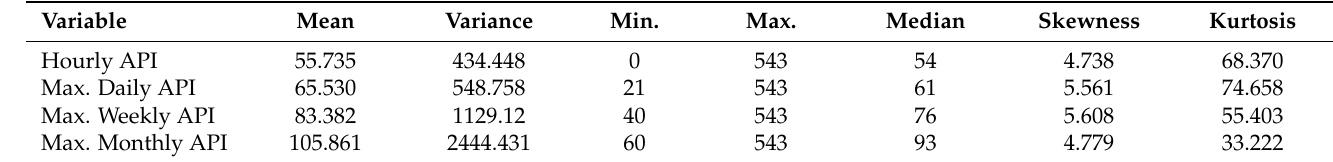
Figure 3. Time series plots of maximum API for different time lengths. Table 1. Statistical characteristics of API data for different time